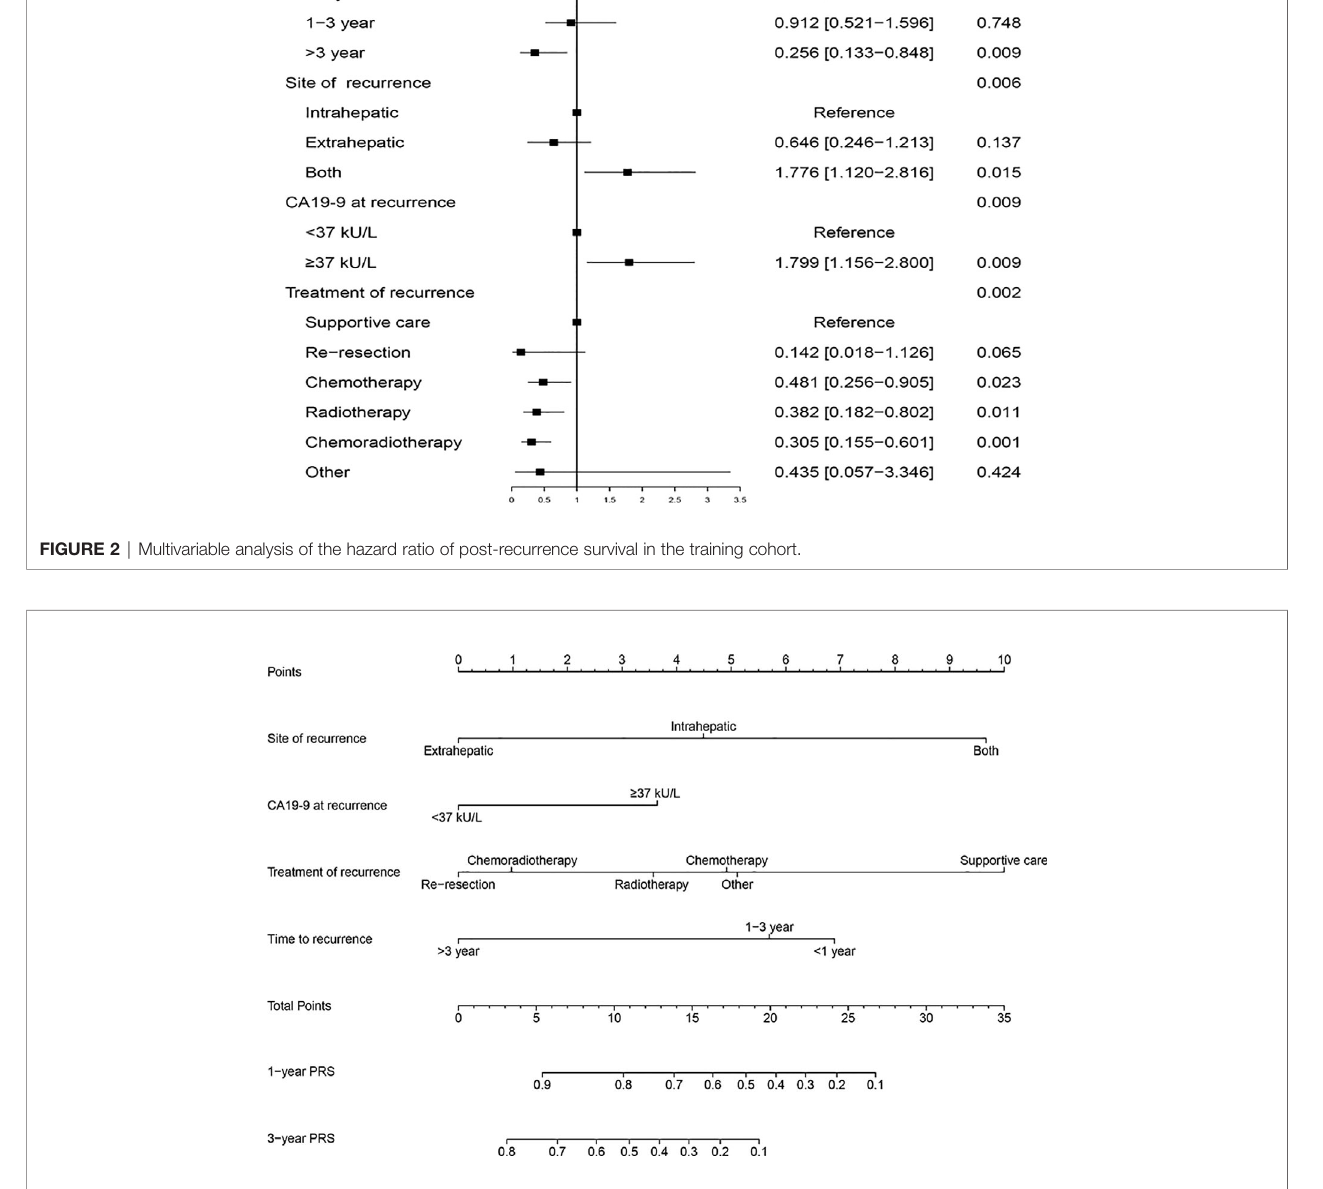
FIGURE 3 | A prognostic nomogram for estimating the 1- and 3-year post-recurrence survival rates in the gallbladder cancer patients with recurrence after